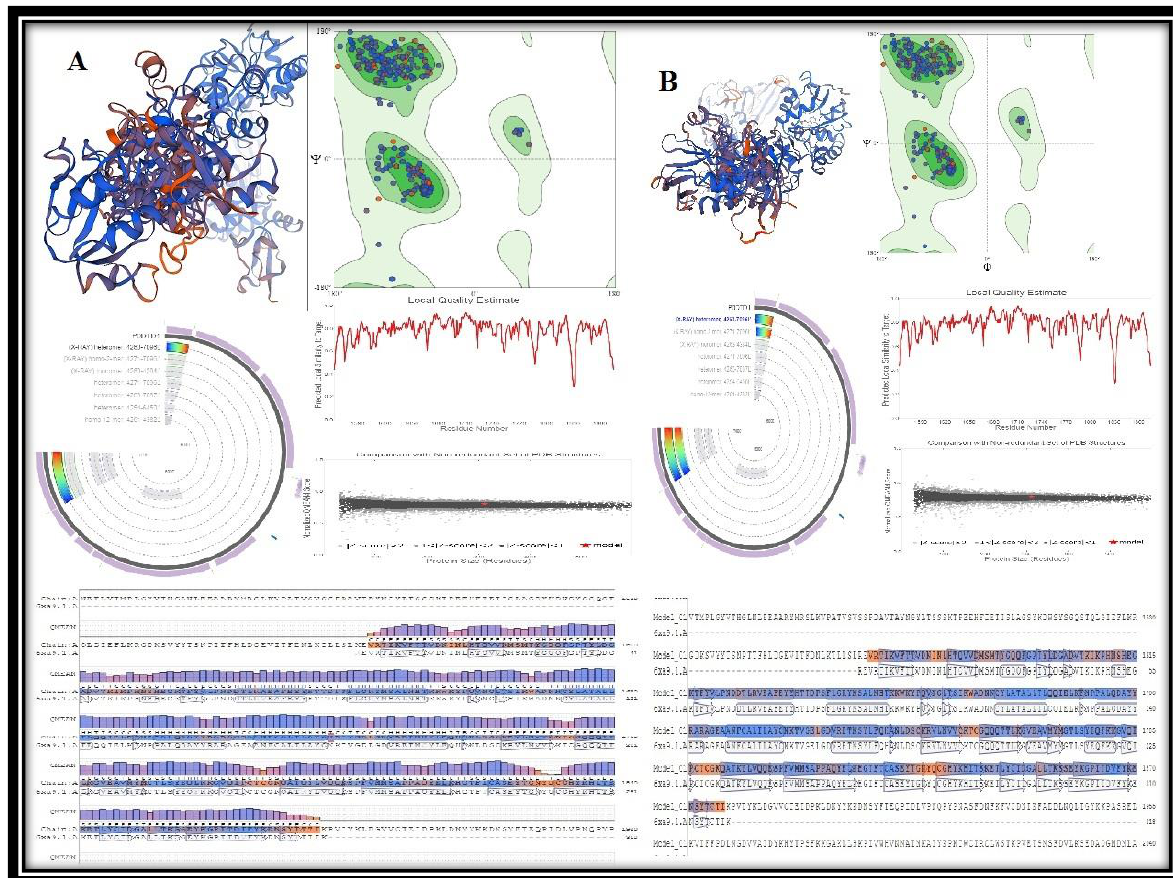
Figure 4. Conformation of protein from COVID-19, (A: Bat Coronavirus and B:human